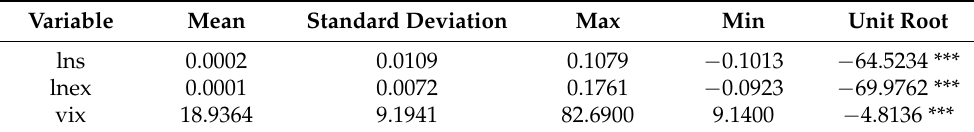
Table 1. Summary Statistics.